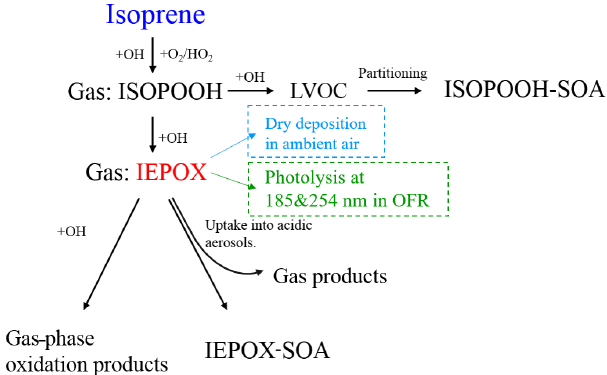
Figure 3. Mechanism diagram of gas-phase IEPOX model in am- bient and OFR conditions. ISOPOOH-SOA refers to SOA formed through gas-particle partitioning of low-volatile VOCs from oxida- tion of isoprene 4-hydroxy-3-hydroperoxide (4,3-ISOPOOH) under low-NO conditions (Krechmer et al., 2015).